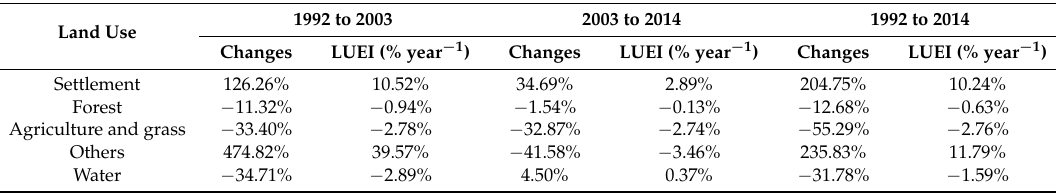
Table 3. Changes in land use types in Denpasar from 1992 to 2014 in percent and the land use expansion index (LUEI) value (% year − 1 ).